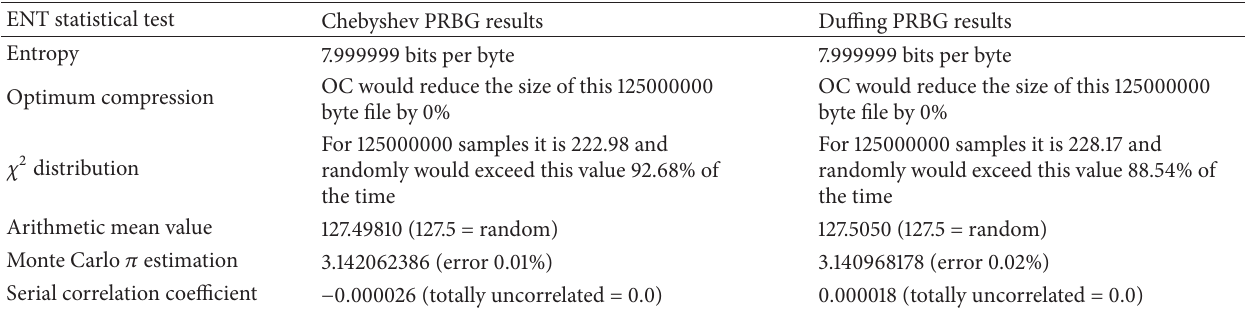
Table 3: ENT statistical test results for two 80 million bits sequences generated by the proposed Chebyshev polynomial based pseudorandom bit generator and Duffing map based pseudorandom bit generator,